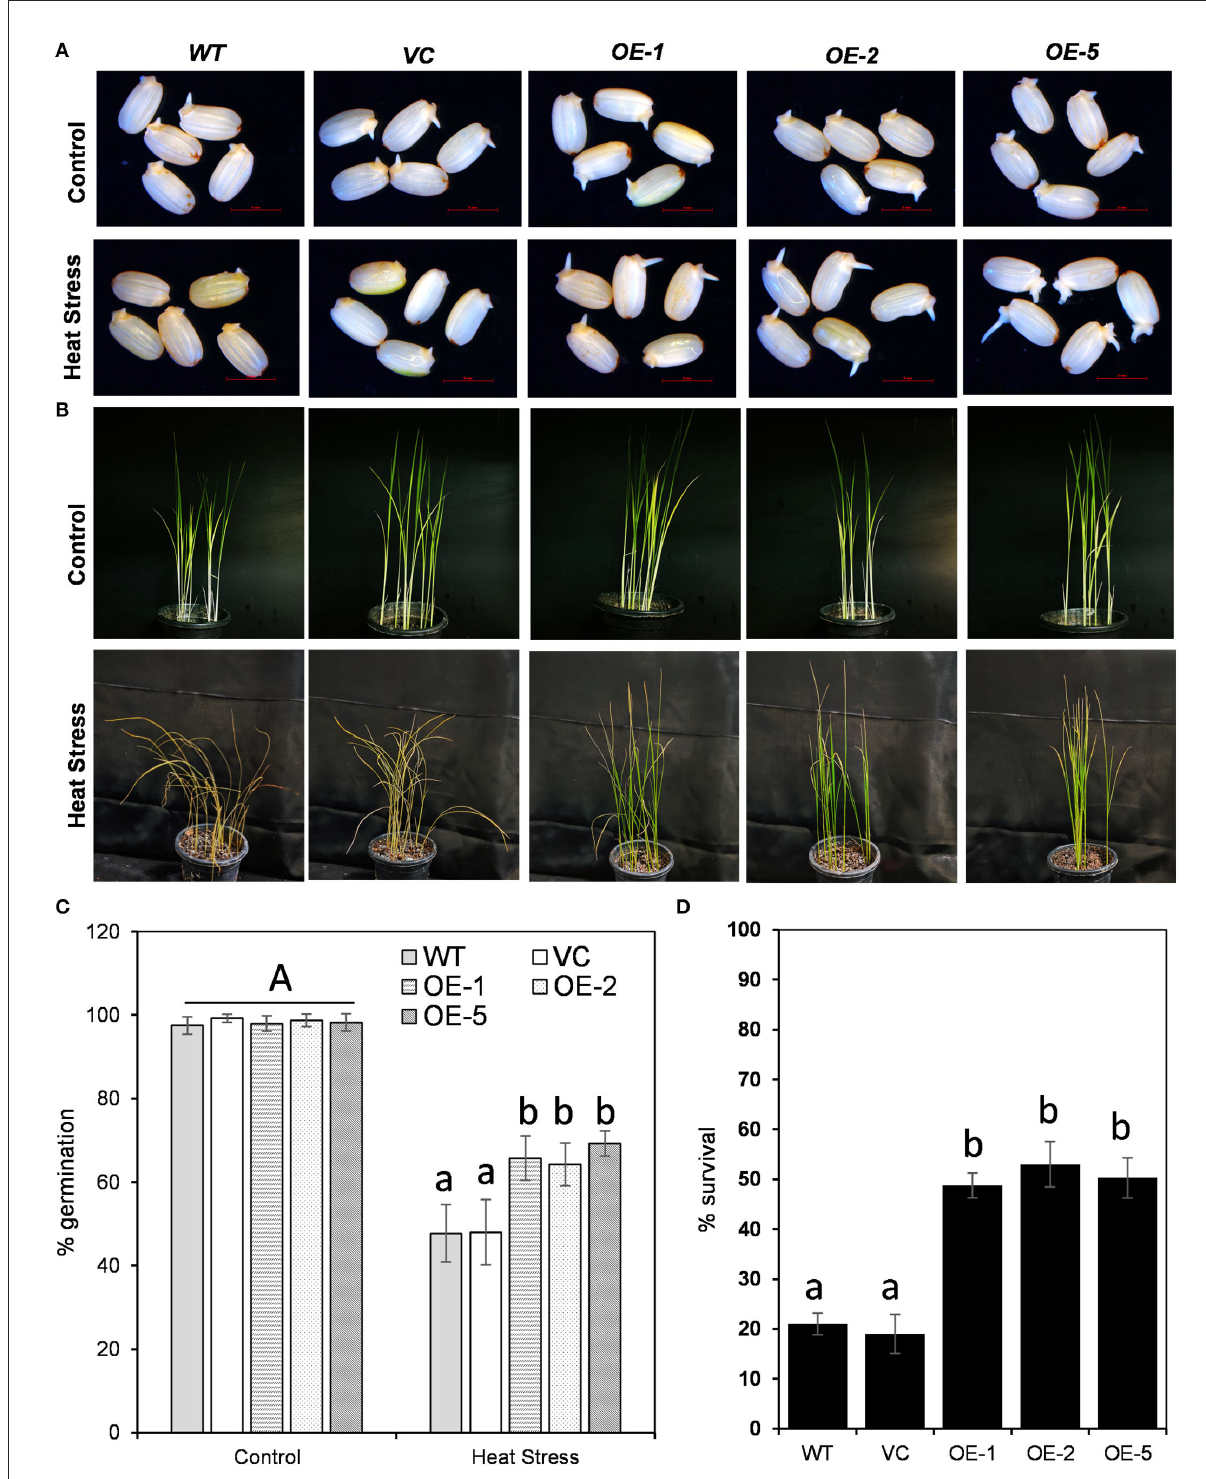
FIGURE6 Comparative stress tolerance potential of transgenic lines overexpressing OsDOF27 and its control counterpart (WT, wildtype plants, and VC, vector control plants) at (A) germination stage and (B) seedling stages. (C) quantitative analysis of percent germination and (D) percent survival of transgenic lines overexpressing OsDOF27 in comparison to WT and VC under heat stress treatment. The error bars represent the standard deviation of triplicate analysis. The significant difference in the mean of the values is indicated by different letters ( α =